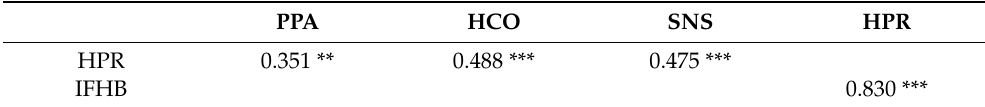
Table 6. Construct